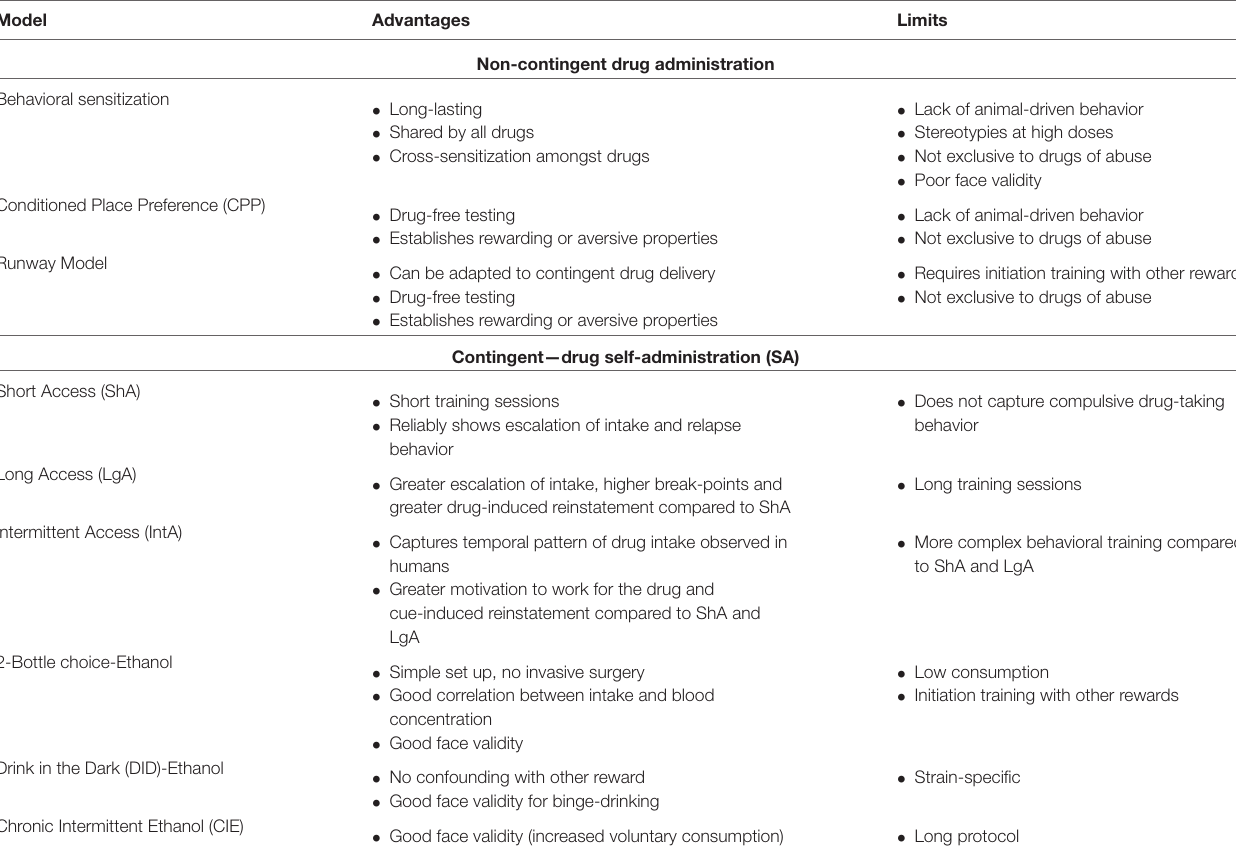
TABLE 1 | Brief summary of preclinical behavioral models most currently used to study the neurobiology of addiction: non-contingent drug administration and contingent drug self-administration